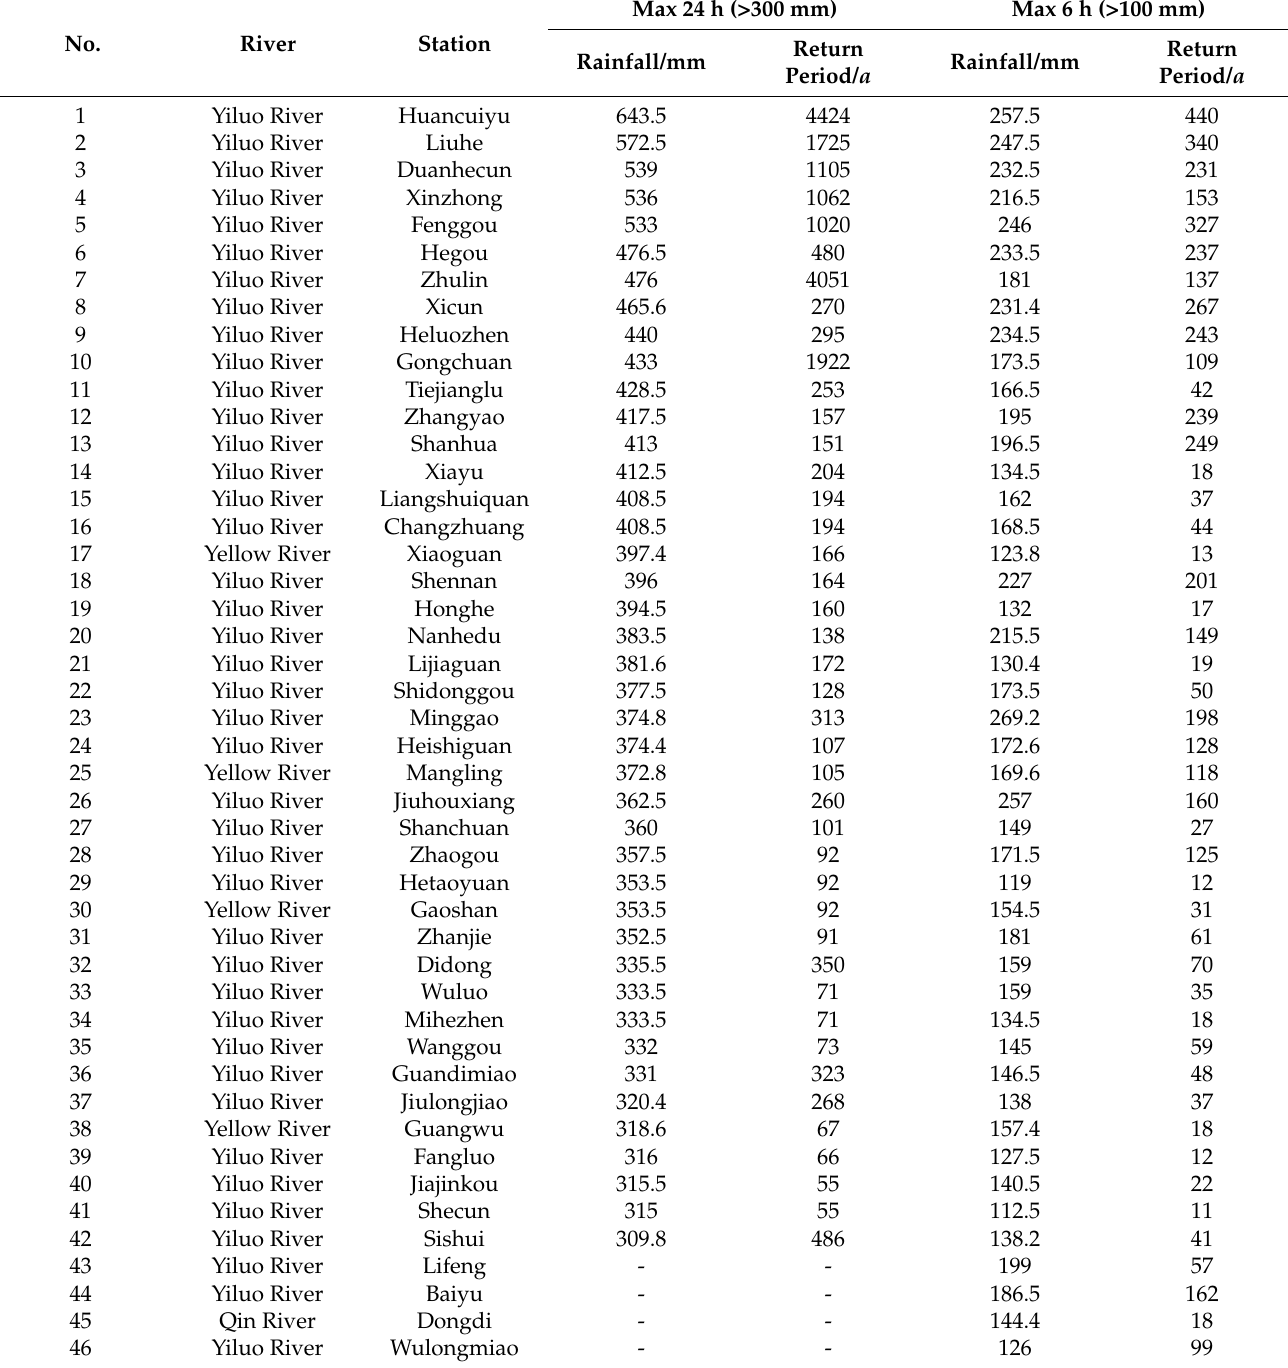
Table 5. The return period of rainfall in different periods of each station in “7.20”